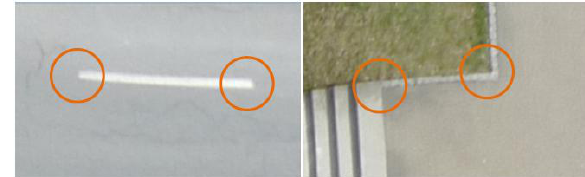
Figure 10. Road marking and curb edges, which can be used as natural control points (highlighted with orange circles) These clearly visible terrain points can be used as control points if they are measured in the field with real-time kinematic GNSS.